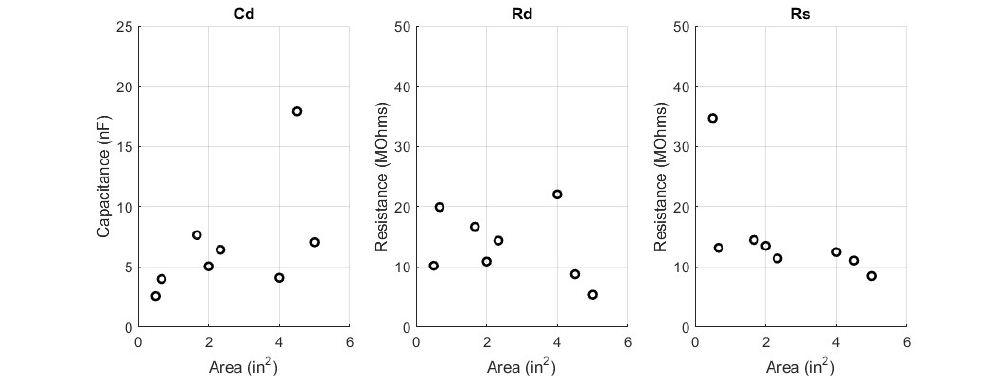
Figure 7. Surface Area Comparison versus Circuit Parameters; Yarn = Spun Steel, Pattern = 1/15 Sateen, C d ( left ), R d ( middle ), R s ( right ).